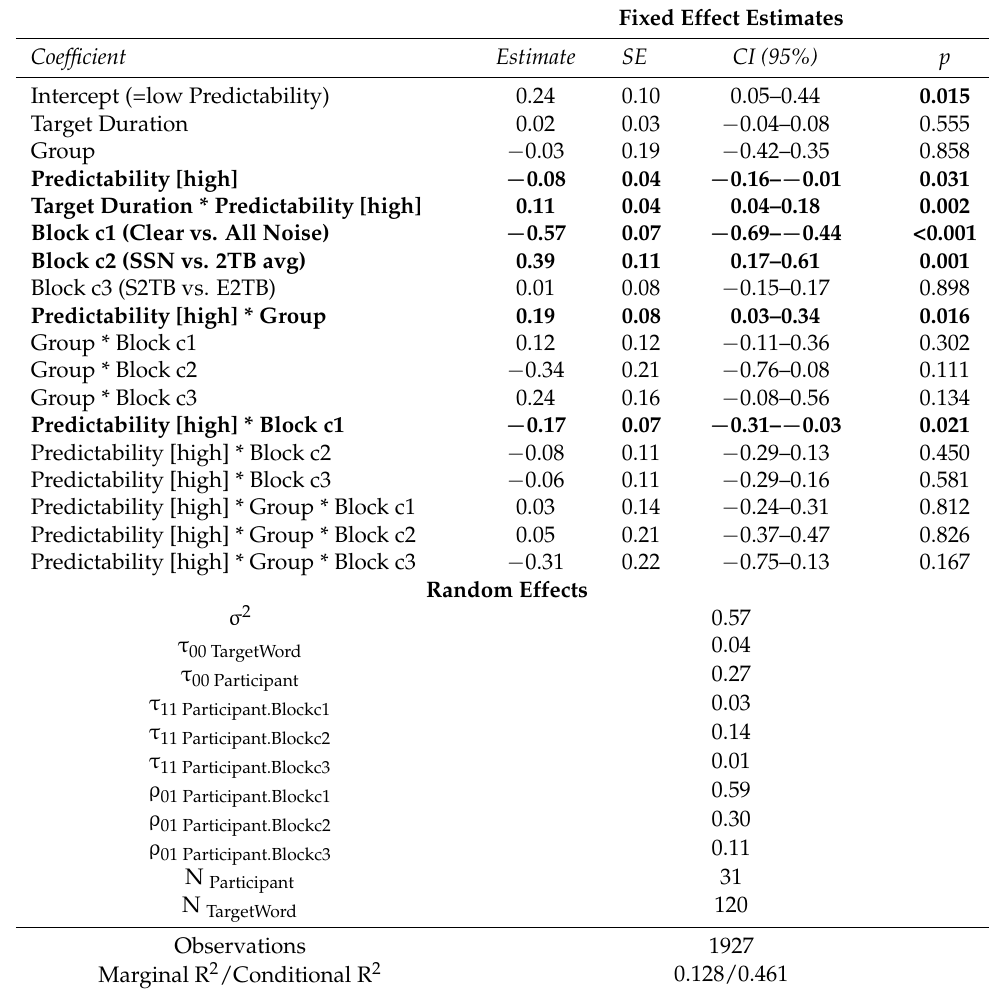
Table 3. Fitted model examining reaction times for accurate keyword responses in the speech-in- noise recognition task.